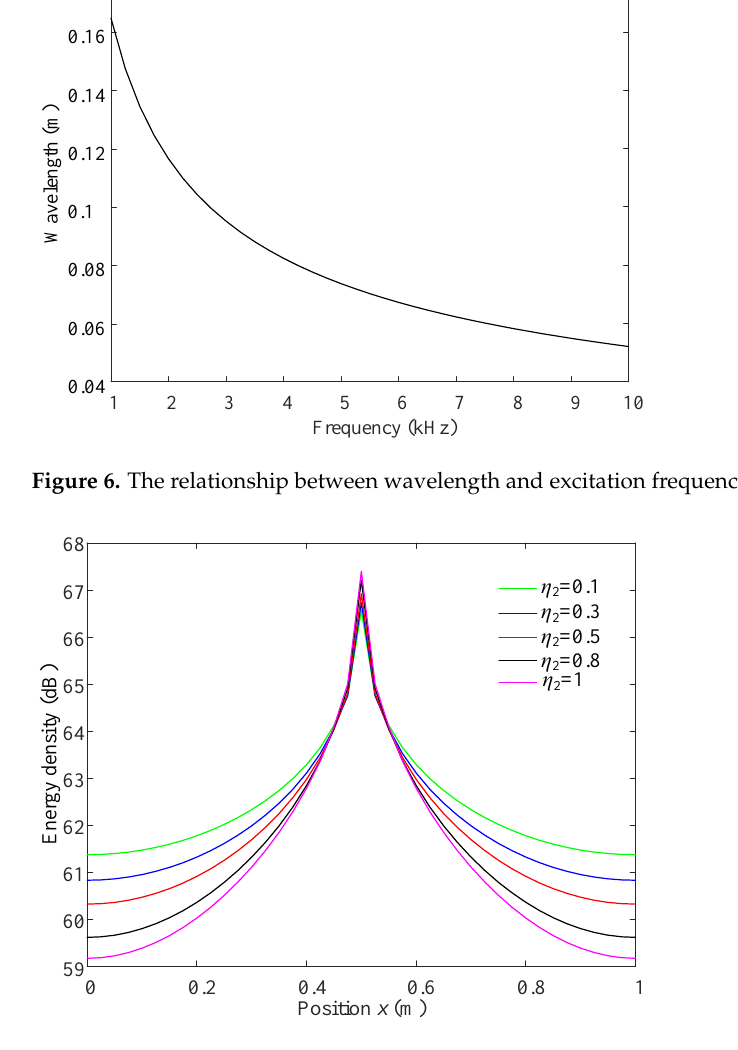
Figure 7. Energy density distribution for a plate with FFLD treatment of various loss factor of damping layer ( f = 3 kHz, h 2 = 0.002 m).